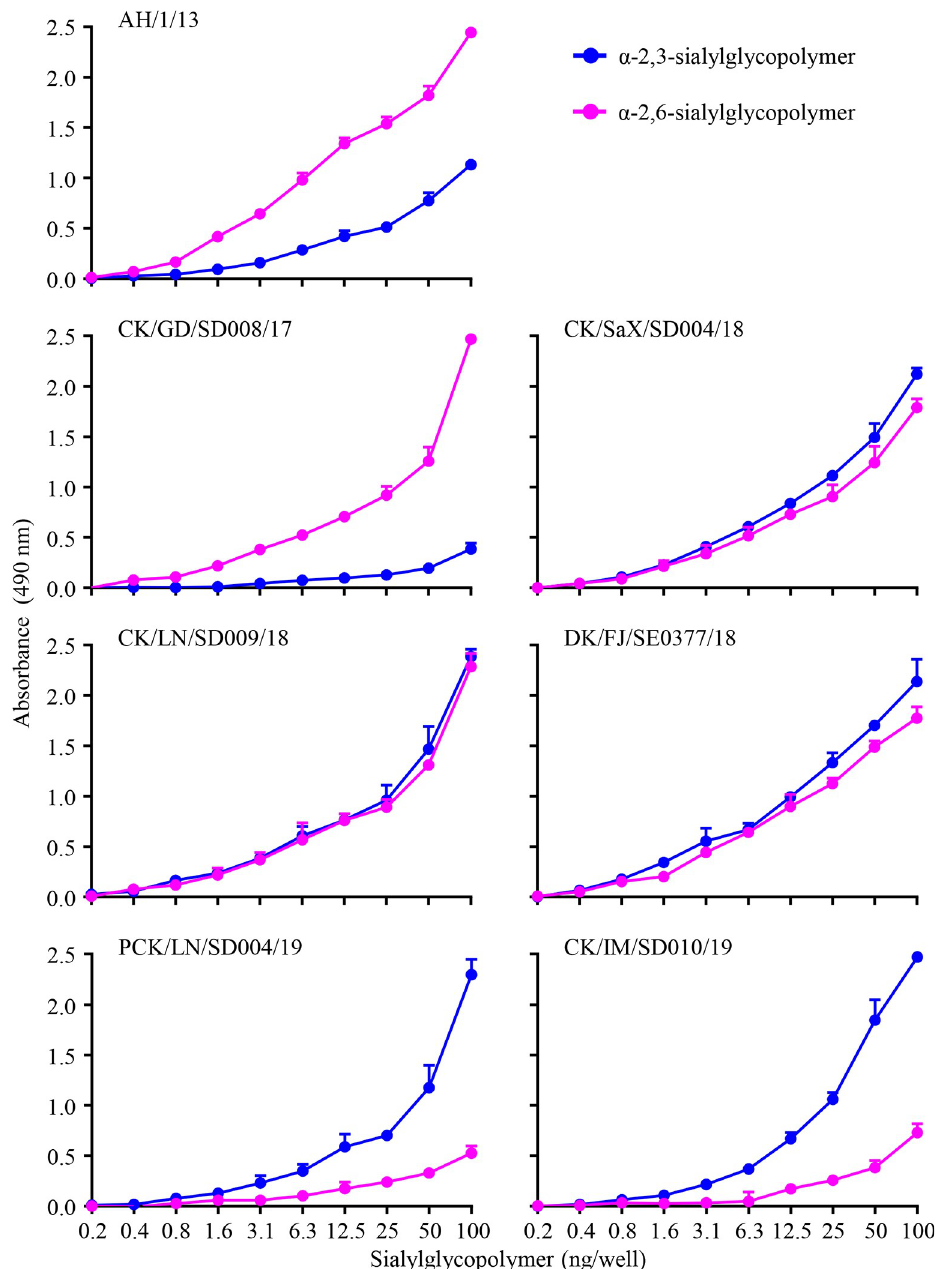
Fig 3. Receptor-binding properties of H7N9 representative viruses isolated between 2013 and 2019. The binding of H7N9 viruses to two different glycans ( α -2,3-glycans, blue; α -2,6-glycans, pink) was assessed. The data shown are the means of three repeats, the error bars indicate standard